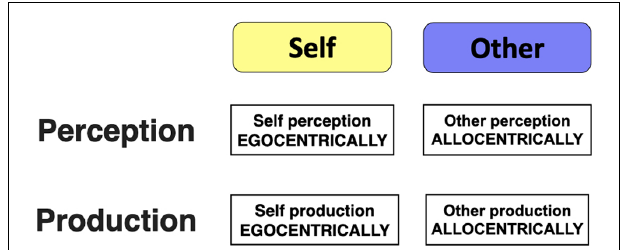
FIGURE 1 | The “standard” mode of social cognition. The standard mode of social cognition is defined as that mode in which the self is processed egocentrically and the other is processed allocentrically, both in perception and production.